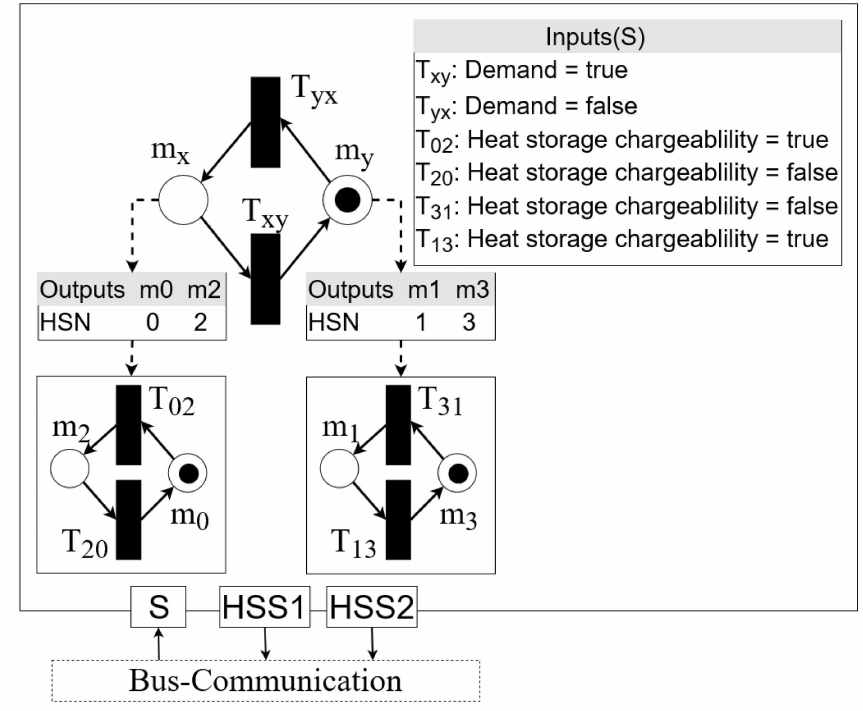
Figure 8. The control model of the heat supply system at the network level based on SIPNs. HSN: heat supply network; HSS1: heat supply subsystem 1; HSS2: heat supply subsystem 2; S: sensor